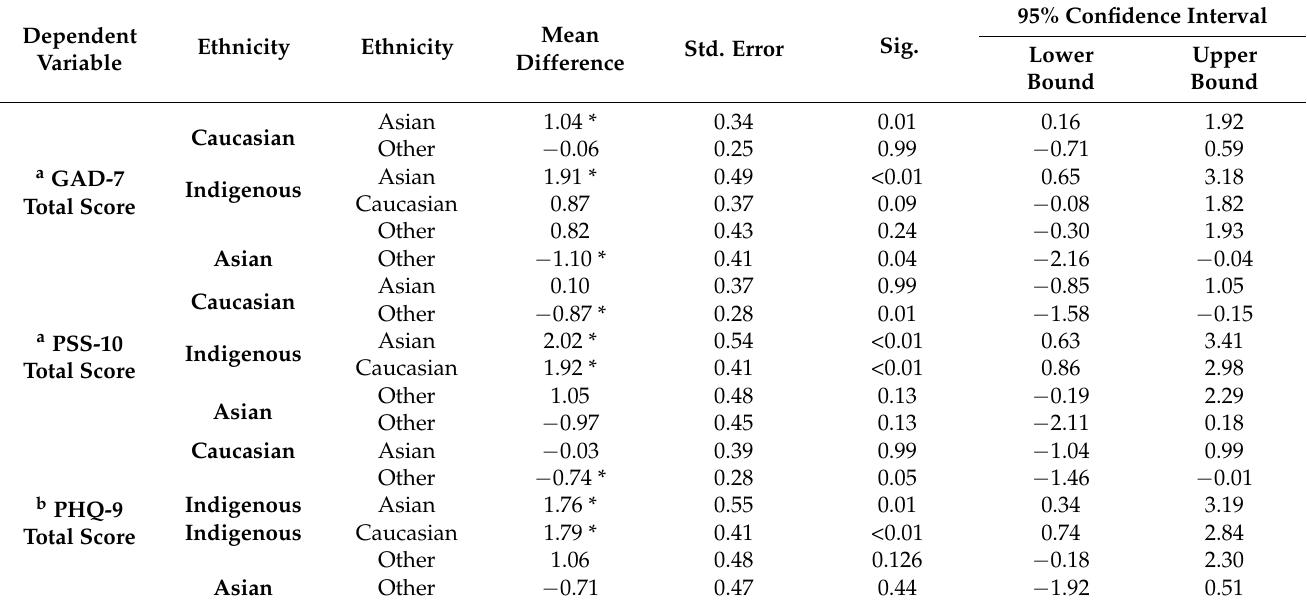
Table 5. Tukey HSD and Games-Howell post-hoc multiple